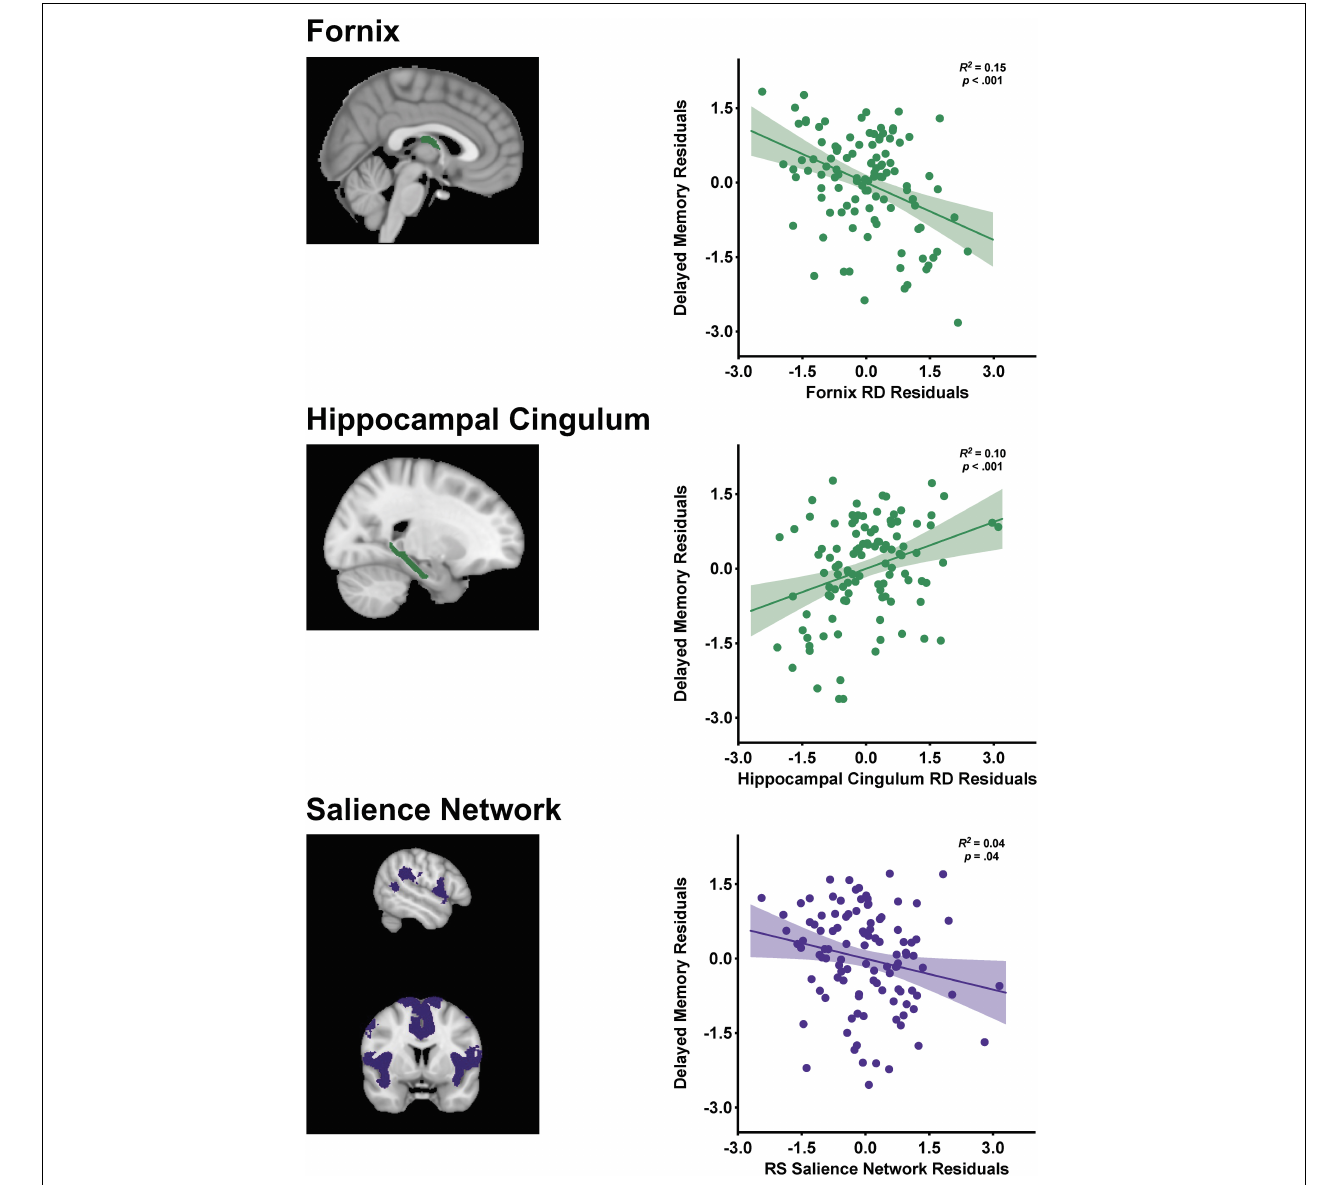
FIGURE 2 | Visualization of the fornix [restricted to the body and column due to resolution constraints], hippocampal cingulum, and salience network with corresponding partial regression plots from the stepwise linear regression with standardized residuals depicting the relationships between the structural and functional connectivity markers with delayed episodic memory performance. Shaded 95% confidence interval